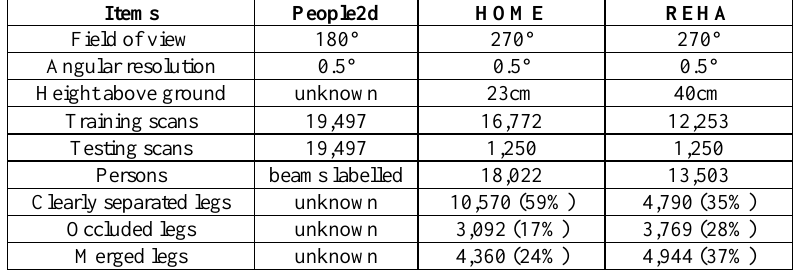
Table 4. Essential characteristics of the laser range finder and data sets